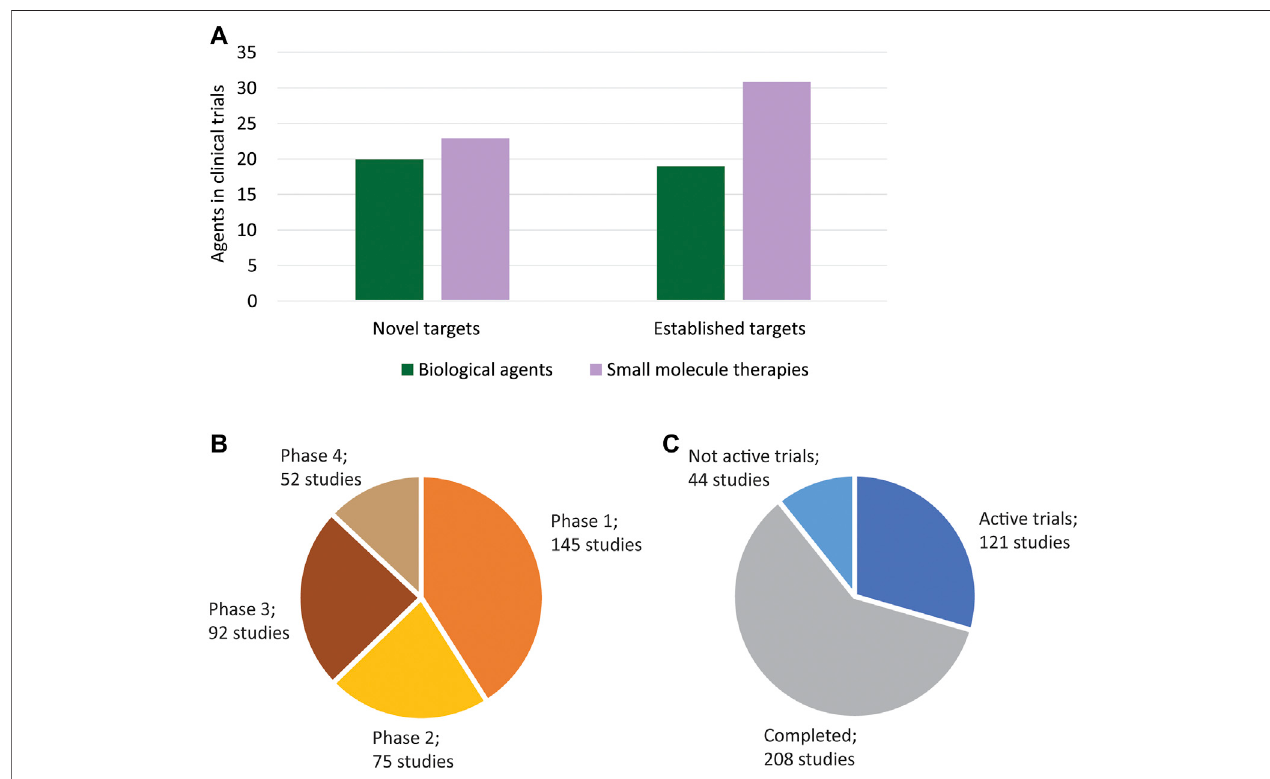
FIGURE 2 | Agents in clinical development. (A) The ∼ 100 antihypertensive agents in clinical development include both biological agents and small molecule therapies. A high number of novel targets (i.e., targets that have not been validated through the approval an FDA-approval antidiabetic agent) are being investigated in clinical development. Novel targets include both single targets and unique combination regimens in trials. (B) ∼ 375 clinical studies associated with the investigative agentshave been registered. A surprising number of agents are in phase 3 trials, indicatingthat more approvals may occur in the near future. Ten studies were not includedastheydidnothaveaphaseidenti fi ed. (C) The121activetrialsincluderegistrationsthathavethesestatuses: active,notrecruiting;enrollingbyinvitation;notyet recruiting ; and recruiting as all of these are soon-to-be active. The 44 not active trials include studies with suspended, terminated, unknown, and withdrawn